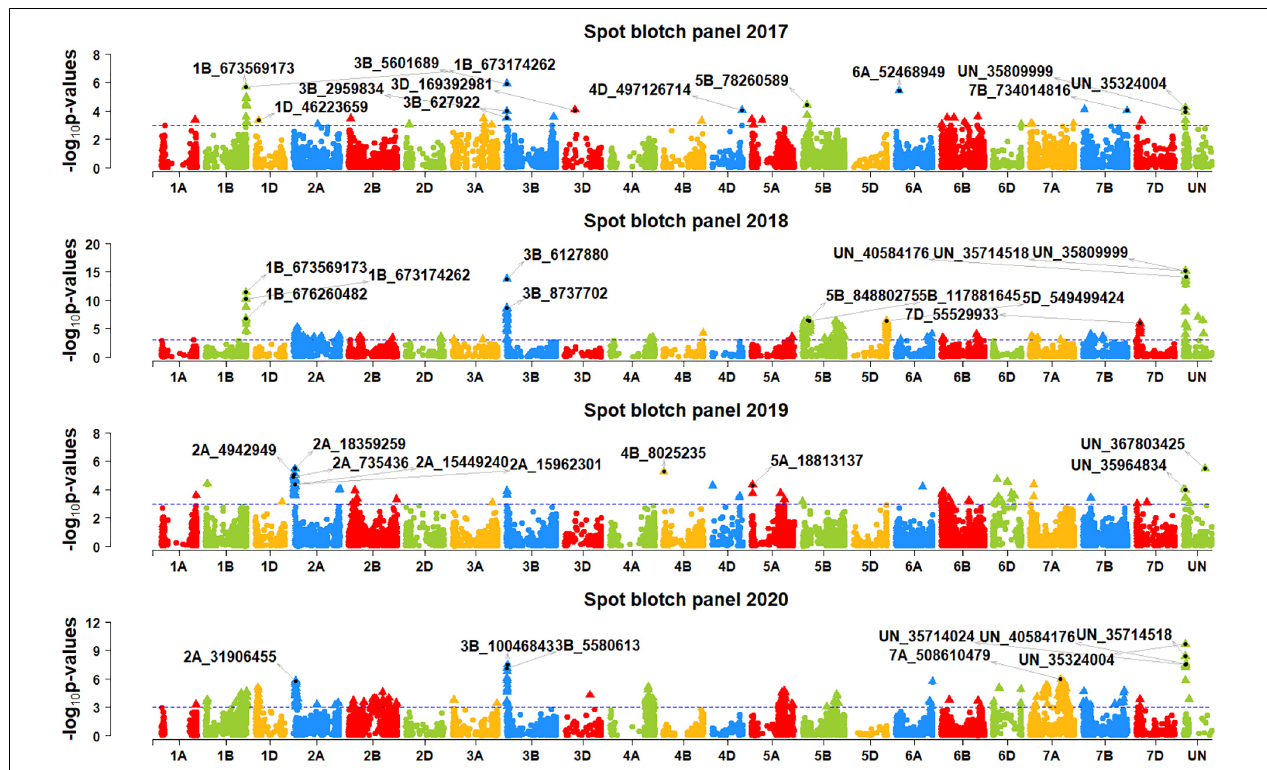
FIGURE 3 | Manhattan plots showing the marker –log 10 p -values and chromosomal positions obtained from genome-wide association mapping for spot blotch in panels 2017, 2018, 2019 and 2020. The blue line indicates the p -value threshold of 0.001 and selected markers that were either very significantly associated with spot blotch or associated in more than one panel are